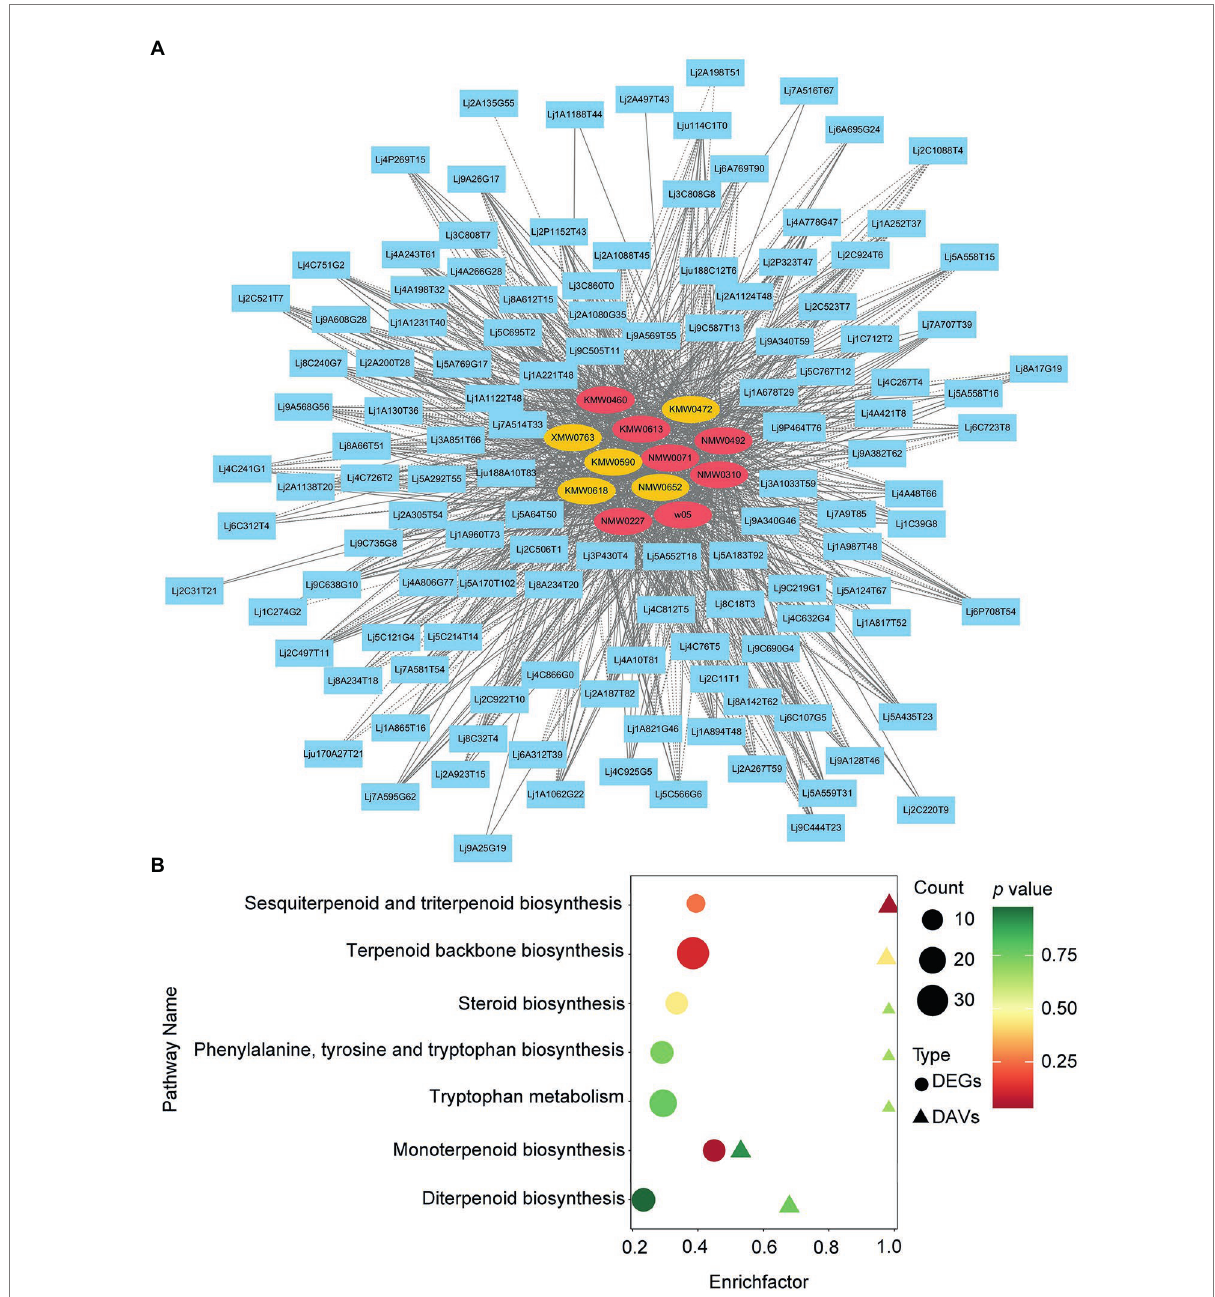
FIGURE 6 Integrated volatile metabolome and transcriptome analysis of VOC accumulation in LJFs. (A) Gene-metabolite correlation network representing DEGs and DAVs. The gene-metabolite pairs are connected by edges. Blue rectangular nodes represent genes. Red and yellow elliptical nodes represent increased and decreased metabolites, respectively. Solid and dashed edges represent positive and negative correlations, respectively. (B) Bubble map of KEGG pathways co-enriched from metabolome and transcriptome data. The ordinate represents KEGG terms, and the abscissa represents the enrichment factor of each